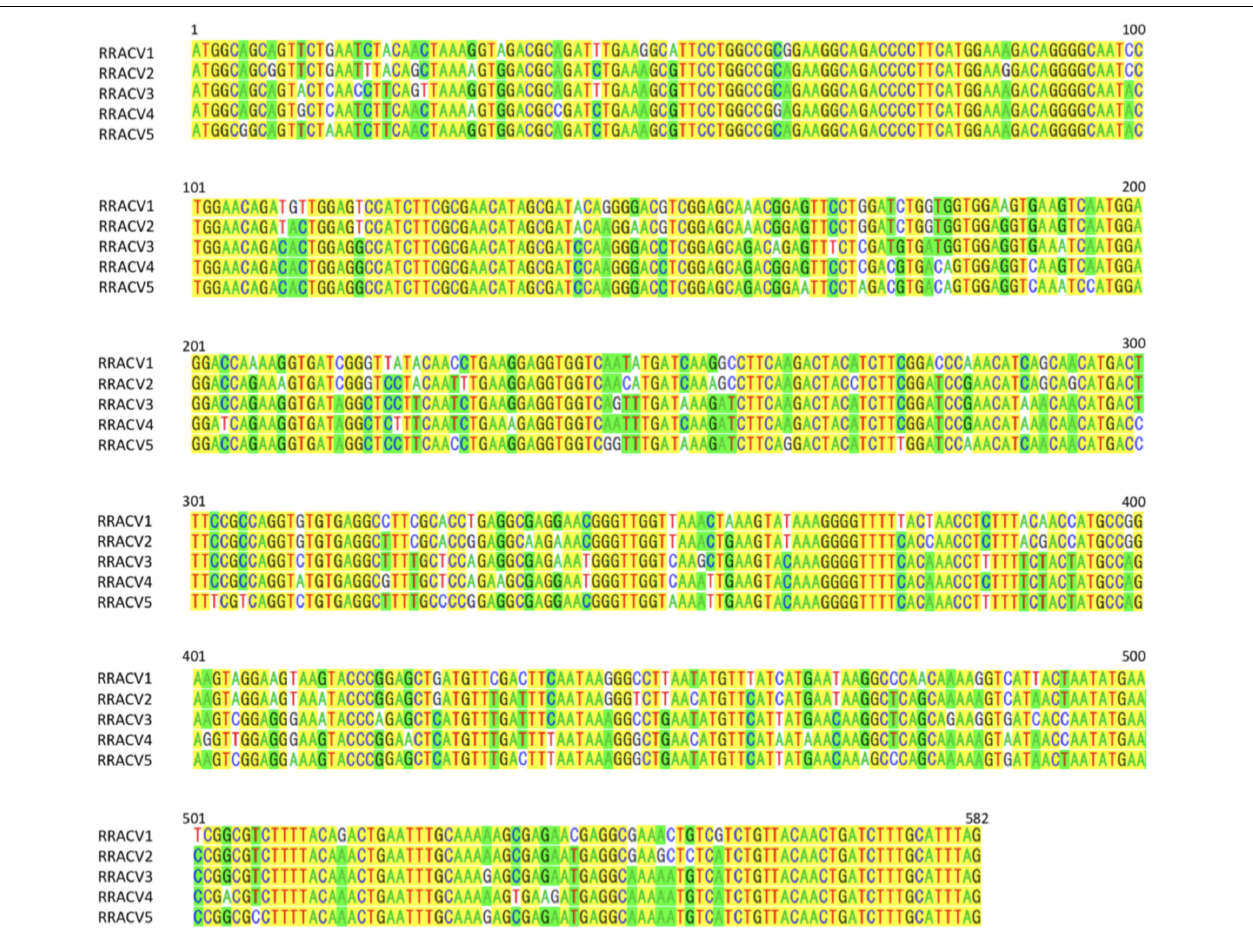
three SVs (RRACV3, RRACV4, and RRACV5) belong to the P205 type and four (RRACV1, RRACV2, SV5, and SV6) belong to the B6